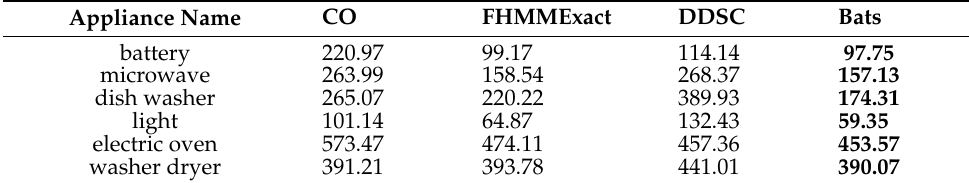
Table 6. RMSE in the REDD dataset.